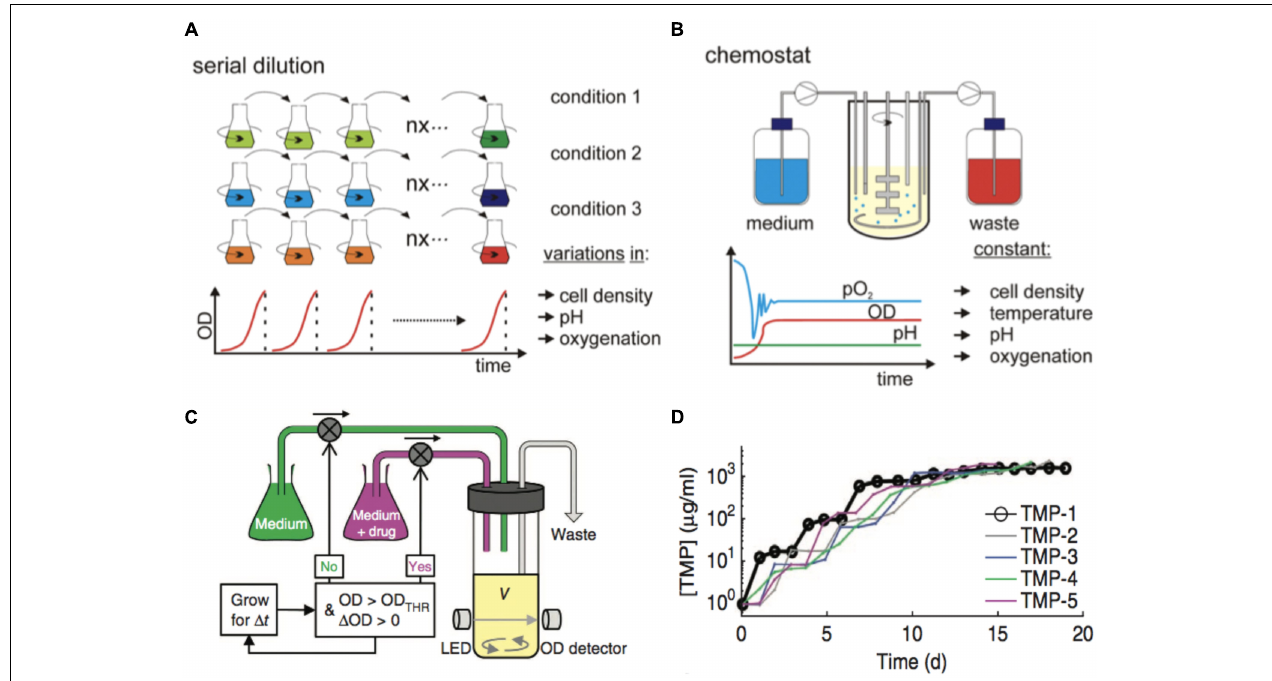
FIGURE 3 | Adaptive laboratory evolution experiment. (A) Serial dilution passage in shaker flasks is often performed manually (Dragosits and Mattanovich, 2013). The growth parameters, such as cell density, pH, and oxygen levels can fluctuate during each growth cycle. © BioMed Central. Reproduced with permission. (B) Chemostat operation (Dragosits and Mattanovich, 2013). The evolution experiment can also be performed with a continuous supply of media and dilution of bacterial cell density. The cell density and other environmental conditions, such as temperature, pH, and oxygen levels are kept constant. © BioMed Central. Reproduced with permission. (C) A feedback algorithm based on the measured optical density is implemented for dynamic adjustment of the drug concentration in the morbidostat (Toprak et al., 2012). The device operates similar to the chemostat, at a given OD value it dilutes the culture by pumping extra media, except here the additional media contains higher drug concentration with each cycle. © Nature Publishing Group. Reproduced with permission. (D) Representative results from the morbidostat (Toprak et al., 2012). The IC 50 , defined as the antibiotic inhibitor concentration at which the growth rate is 50% of the maximal growth at zero inhibitor concentration, is displayed for the drug trimethoprim over the course of 20 days. The legend shows the color codes for five parallel evolution experiments. The stepwise increase can be clearly seen. © Nature Publishing Group. Reproduced with